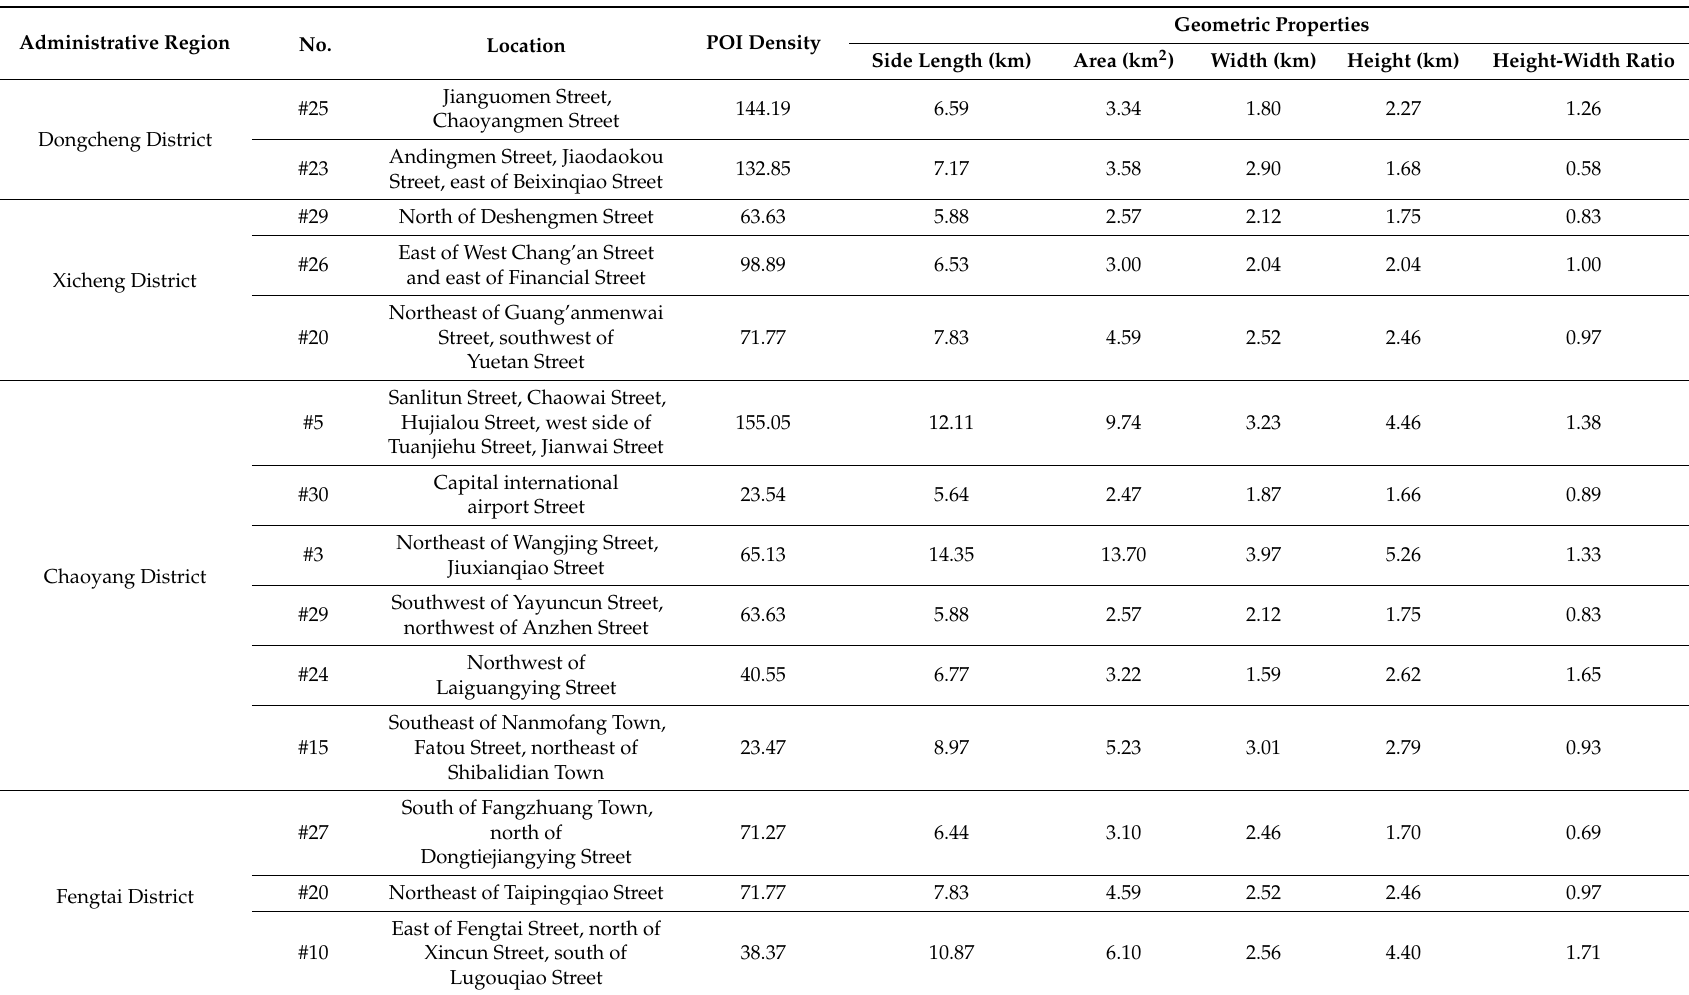
Table 2. Attributes of Beijing’s accommodation and catering industry cluster centers (units: km, km 2 ). Administrative Region No. Location POI Density